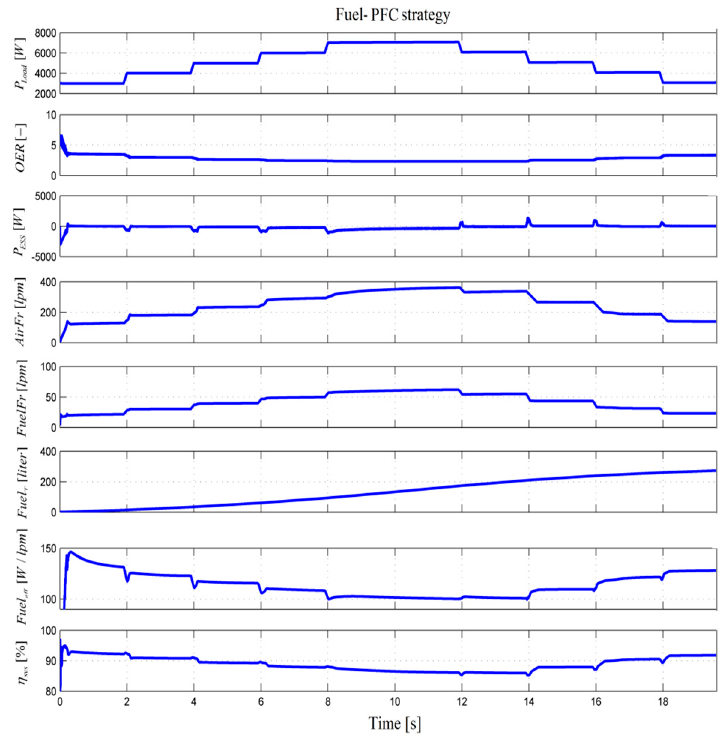
Appl. Sci. 2020 , 10 , x FOR PEER REVIEW Figure 6. FC system behavior using fuel-PFC strategy [34]. Figure 6. FC system behavior using fuel-PFC strategy [34].